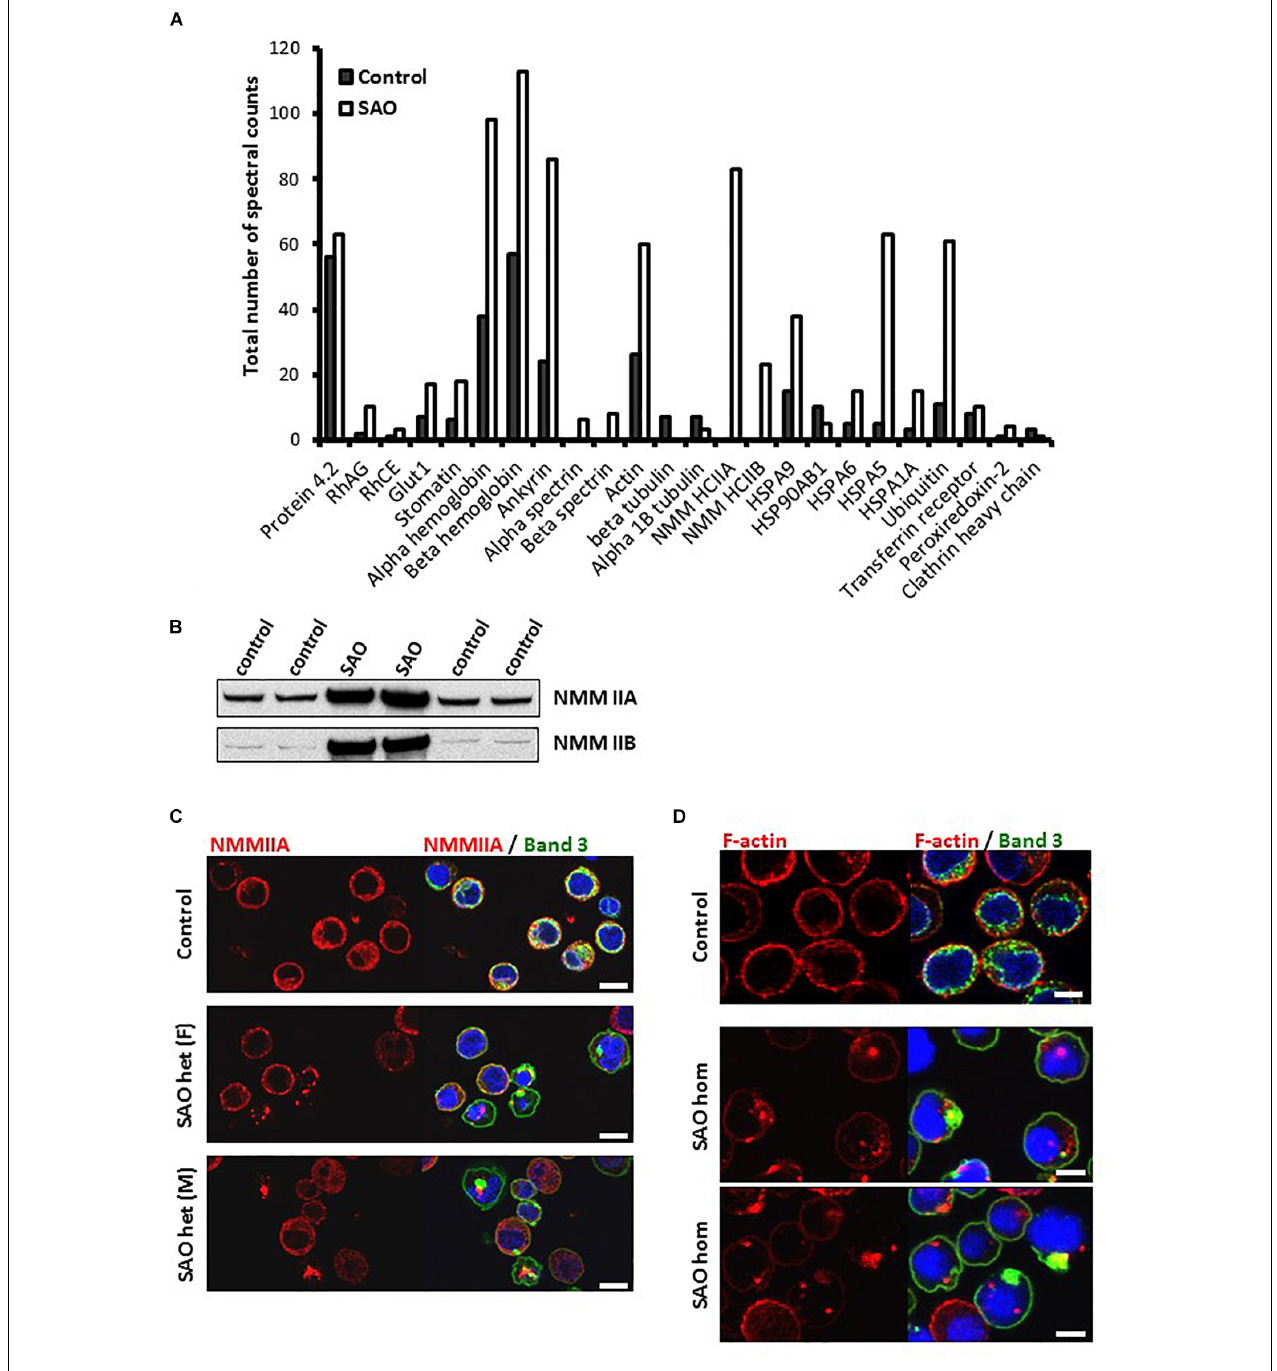
FIGURE 9 | SAO band 3 immunoprecipitation. (A) Band 3 was immunoprecipitated from control (day 14) and homozygous SAO (day 27) cultured CD34 + cell lysates. These stages were not ideal but were chosen in order to match both cell types as closely as possible (predominantly orthochromic erythroblasts and 10% enucleated as shown in Figure 4 ). The immunoprecipitate was analyzed by mass spectrometry. The number of spectral counts obtained for the co-immunoprecipitated proteins from each culture are shown. (B) Immunoblots of control and heterozygous SAO mature erythrocyte membranes. Antibodies used were anti-NMMIIA (ab24762) and anti-NMMIIB (ab24761). (C) Day 14 control and heterozygous SAO cells were stained with anti-NMMIIA antibody (red) and anti-band 3 antibody (BRIC170; green). DNA was stained with DAPI (blue). Scale bars represent 10 µ m. (D) Day 14 cells imaged using anti-band 3 antibody (BRIC170; green) and AlexaFluor 546-conjugated phalloidin, which binds F-actin (red). DNA was stained with DAPI (blue). Images are representative of at least 5 different fields from one experiment. Scale bars represent 5 µ m.